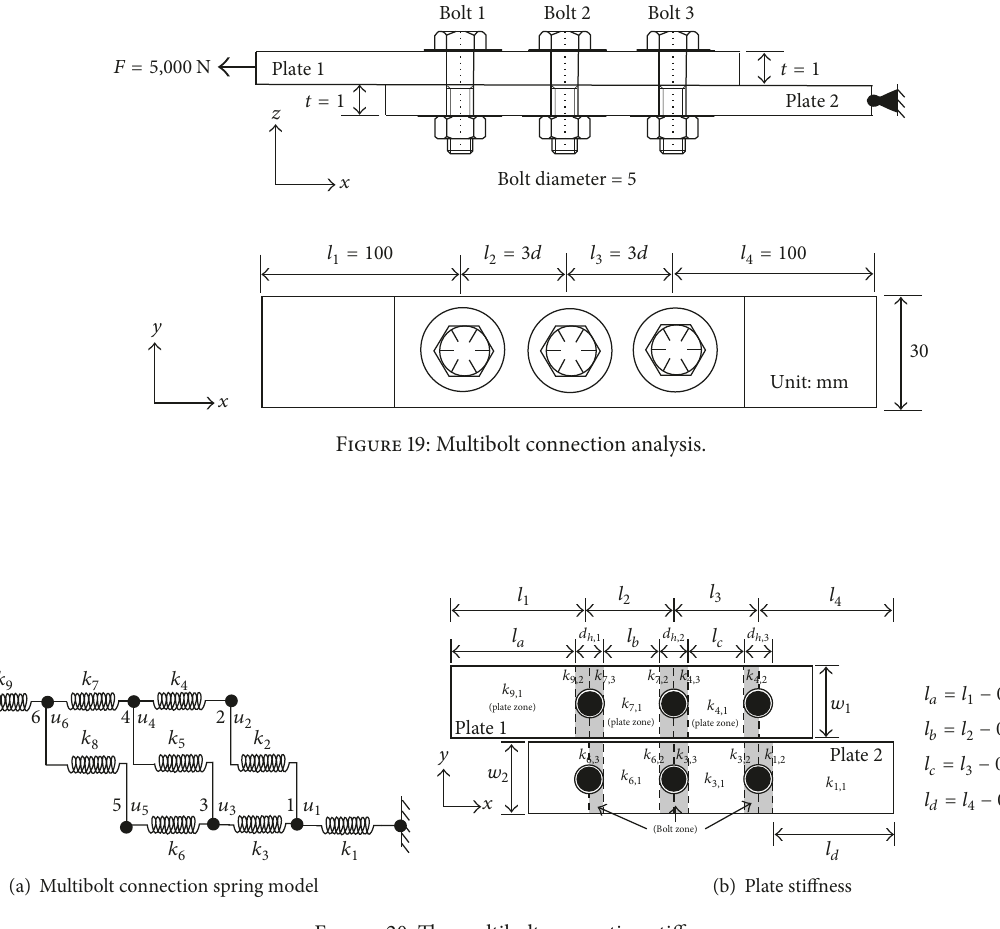
Figure 20: The multibolt connection stiffness.